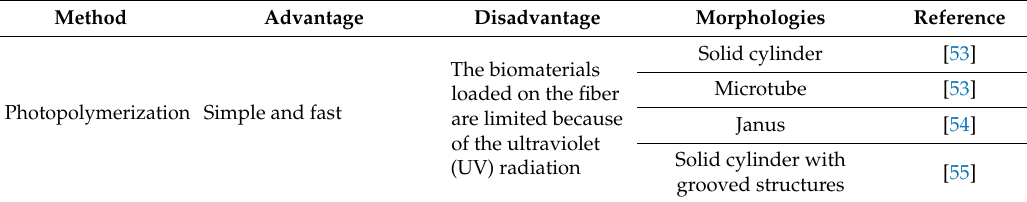
Table 2. Features of three main methods used in microfluidics spinning used to fabricate